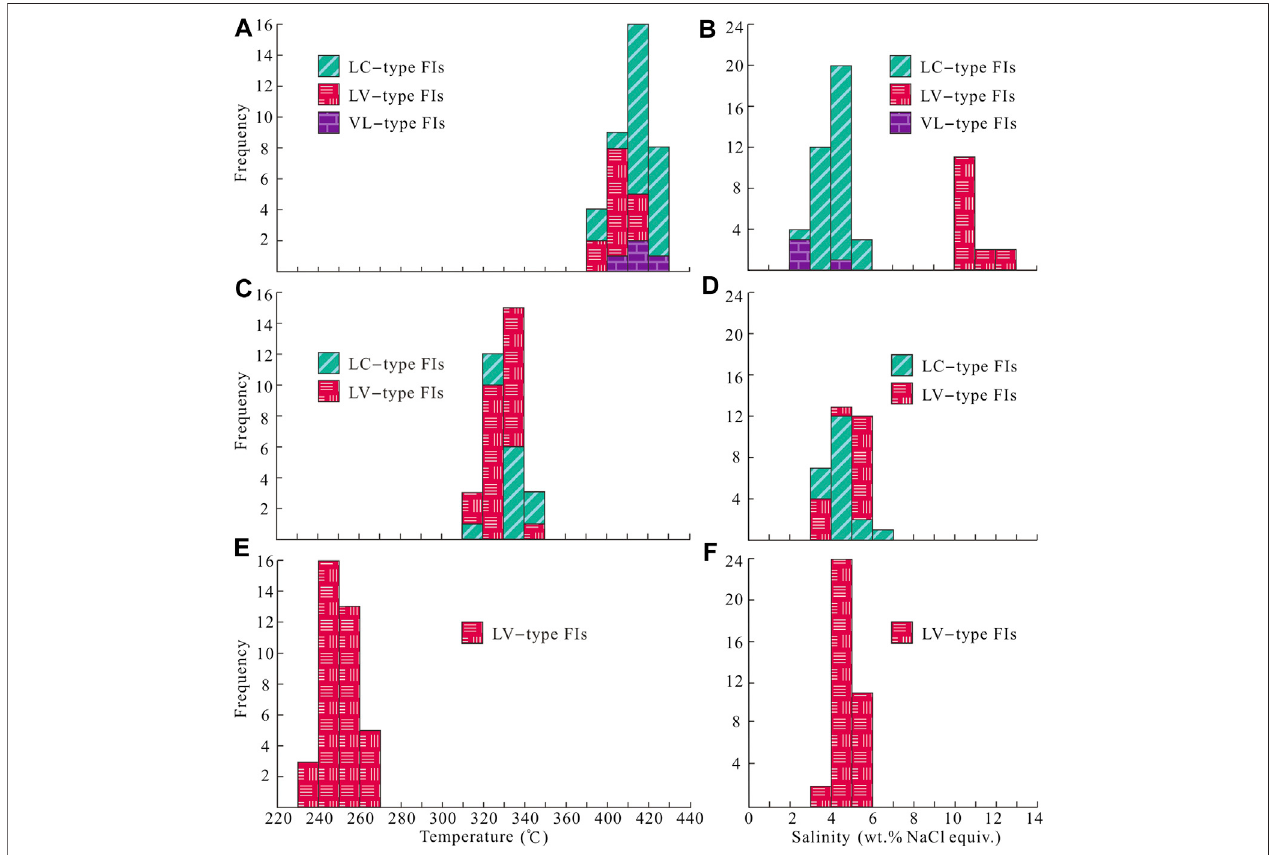
FIGURE 5 | Histograms of microthermometric data for FIs in quartz of the Jinba gold deposit. (A) Homogenization temperatures for LC – , VL – and LV – type FIs of stage 1. (B) Salinity for LC – , VL – and LV – type FIs of stage 1. (C) Homogenization temperatures for LC – and LV – type FIs of stage 2. (D) Salinity for LC – and LV – type FIs of stage 2. (E) Homogenization temperatures for LV – type FIs of stage 3. (F) Salinity for LV – type FIs of stage 3.